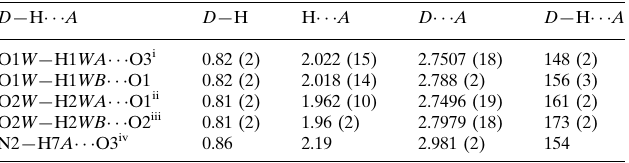
Hydrogen-bond geometry (A˚ , (cid:2)